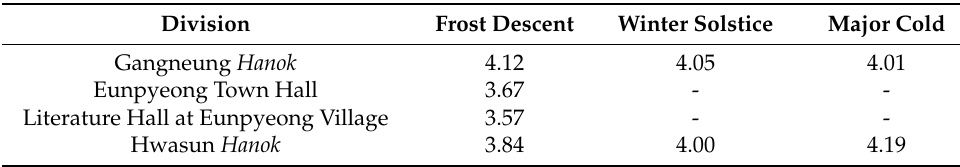
Table 11. Condensation survey